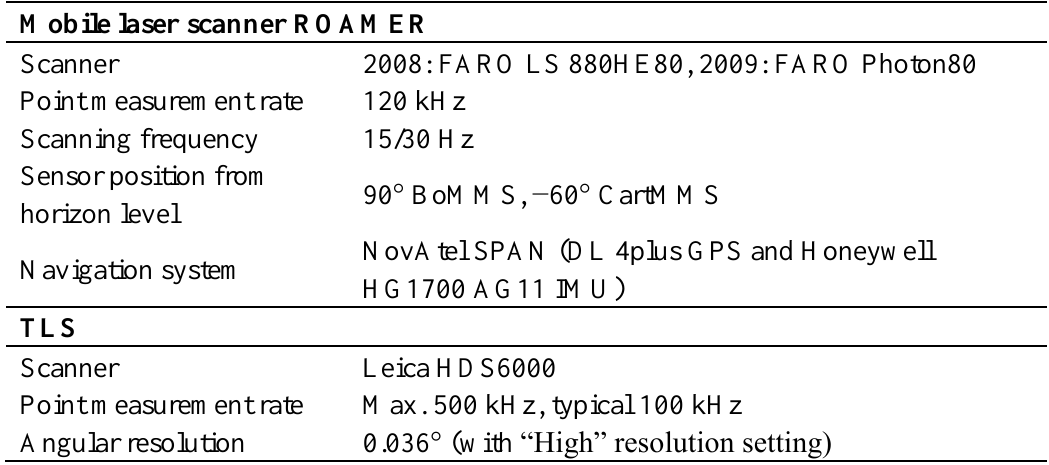
Table 1. Laser scanning system